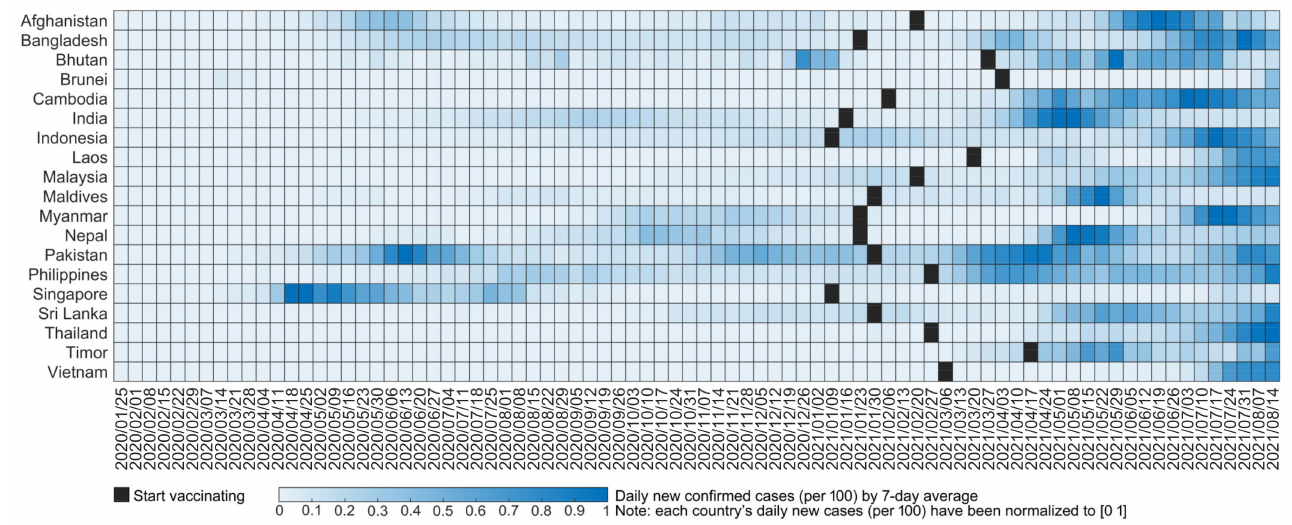
Figure 1. Daily new confirmed cases (per 100) in 19 countries of South and Southeast Asia (the daily new cases (per 100) for each country have been normalized to (0, 1) to clearly show the